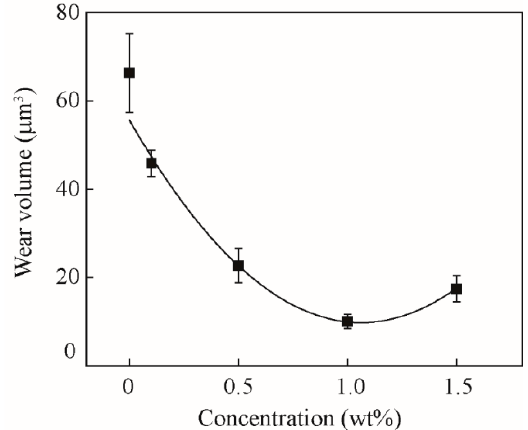
Figure 7. Wear volume of surfaces lubricated by oils with different concentrations of lamellar ZrS 2 nanobelt additives.